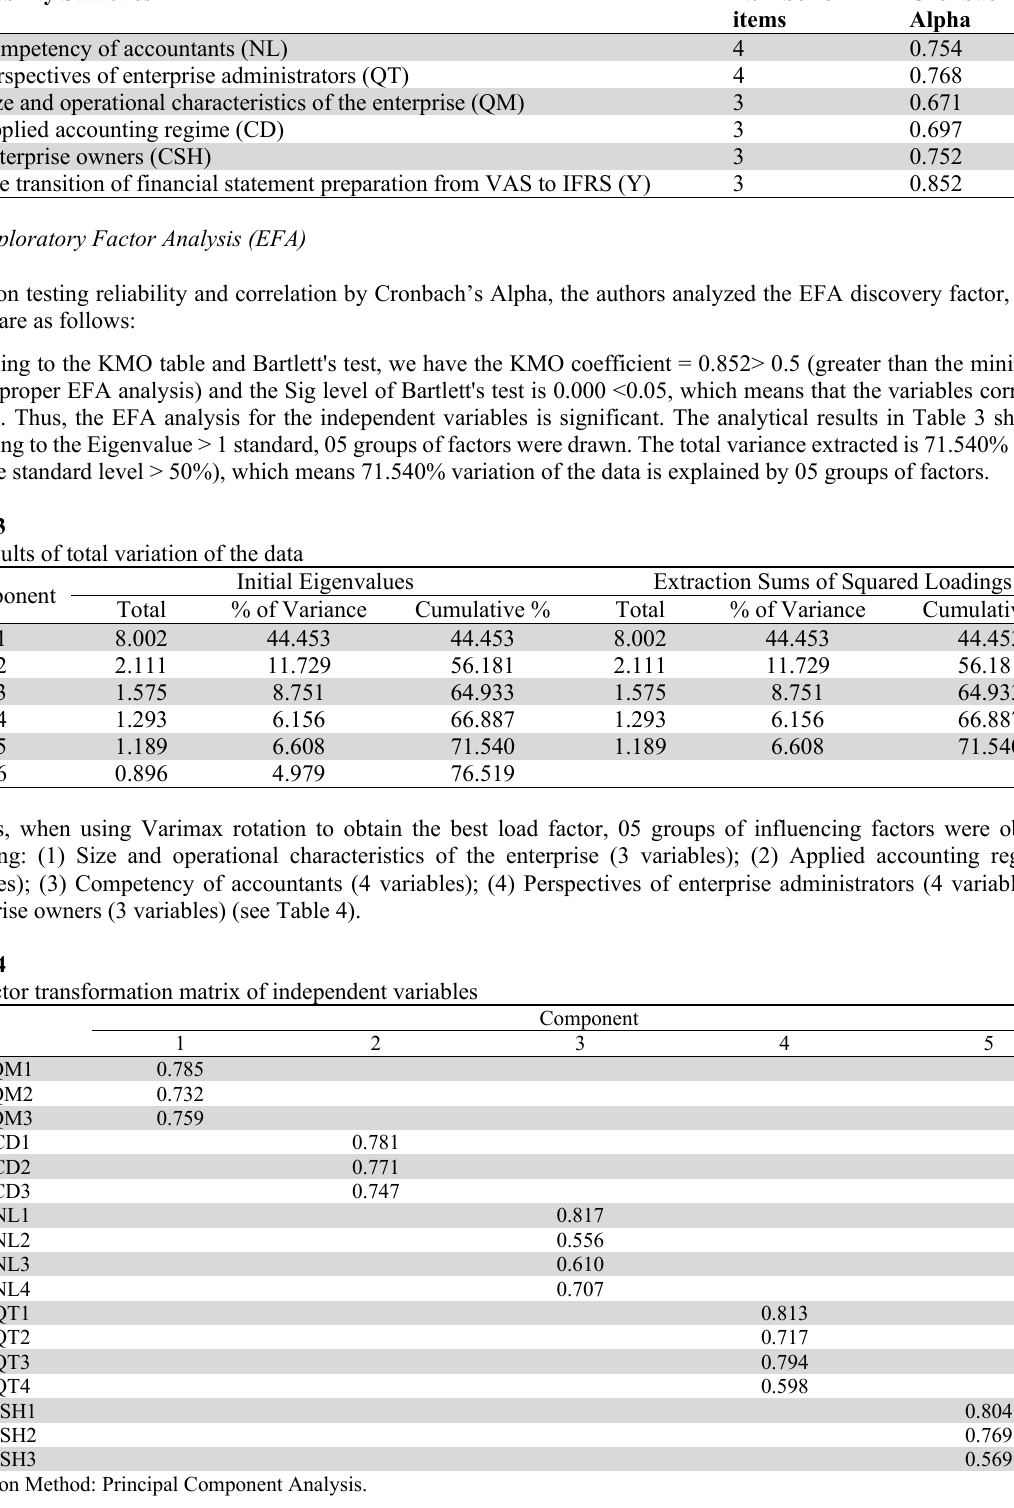
The Cronbach’s Alpha coefficient of the independent variable and the dependent variable Reliability Statistics